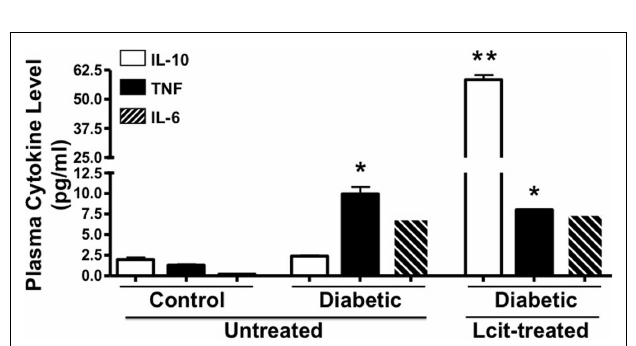
FIGURE 6 | Plasma cytokine level . Mouse plasma samples were used for cytokine and chemokine measurement, using a magnetic bead-based multiplex assay. L -Cit induced an anti-inflammatory response in diabetic mice, as observed by significant increased levels of IL-10.Values are mean ± SEM. * p < 0.001 vs. untreated control mice, ** p < 0.001 vs. untreated control and diabetic mice.